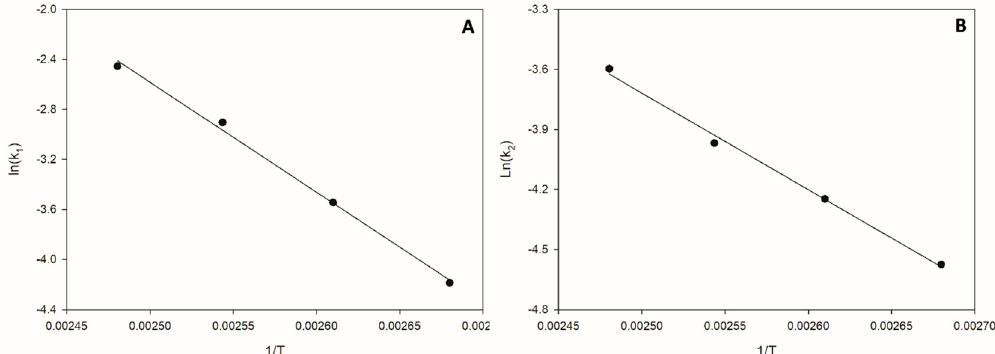
Figure 4. Arrhenius plots for methanolysis reactions at 130 - 100 °C, the best rate coefficients were selected from Table 4. ( A ) = k 1 y = -8784.9x + 19.379 R 2 = 0.9963 ( B ) = k 2 y = -4829.9x + 8.357 R 2 = 0.9953. Table 6. The activation energies for each step of PLA methanolysis.